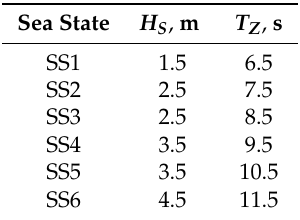
Table 4. Significant wave height and wave period for considered sea